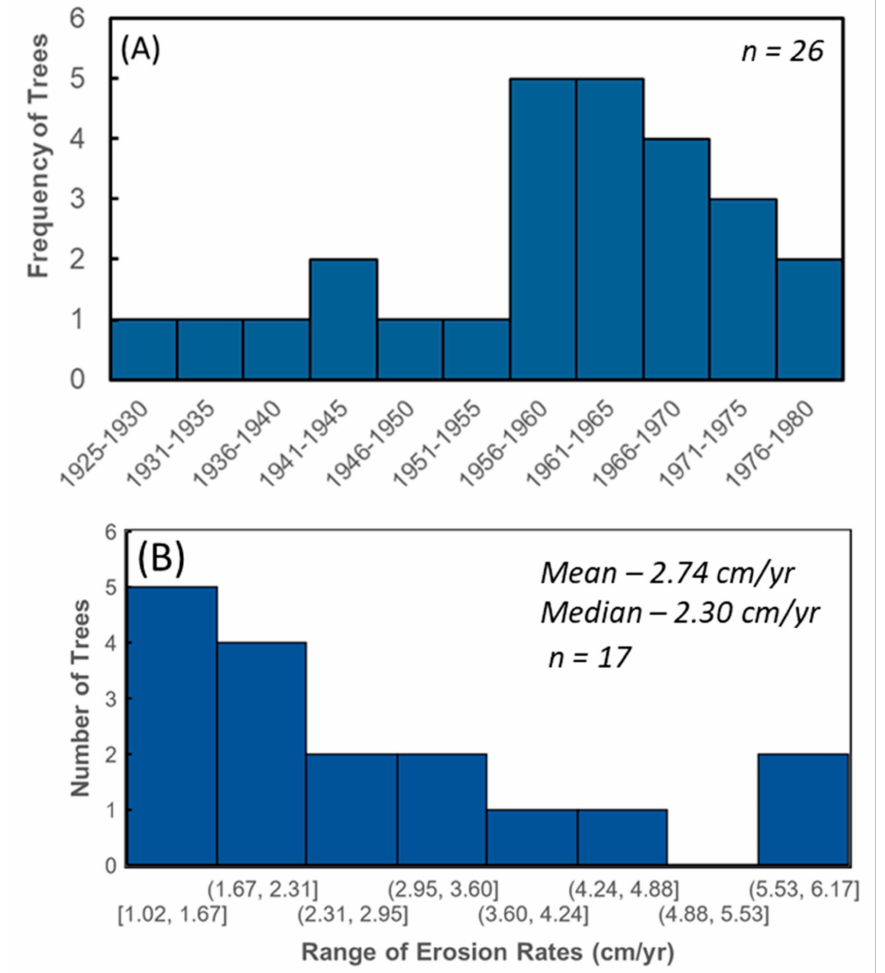
Figure 6. ( A ) Histogram showing the variation in the approximate age of the trees on the valley floor of entrenched alluvial channels. Age does not account for collection of tree cores at ~1 m above ground. Exact date of germination is likely to be 2–5 years prior to date shown; ( B ) rates of bank erosion estimated from tree age and width of exposed tree roots from channel banks. Includes trees from along Stick Elliott Creek, Upper Big Harris Creek, and Royster Creek. Figure updated from Miller et al.